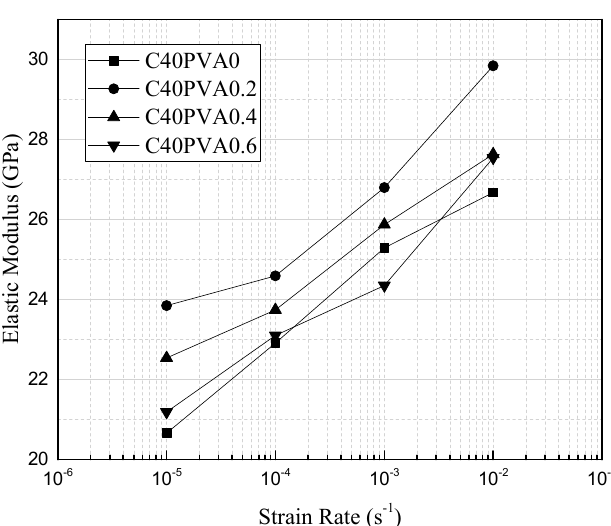
Figure 11. Elastic modulus of FRC (C40).